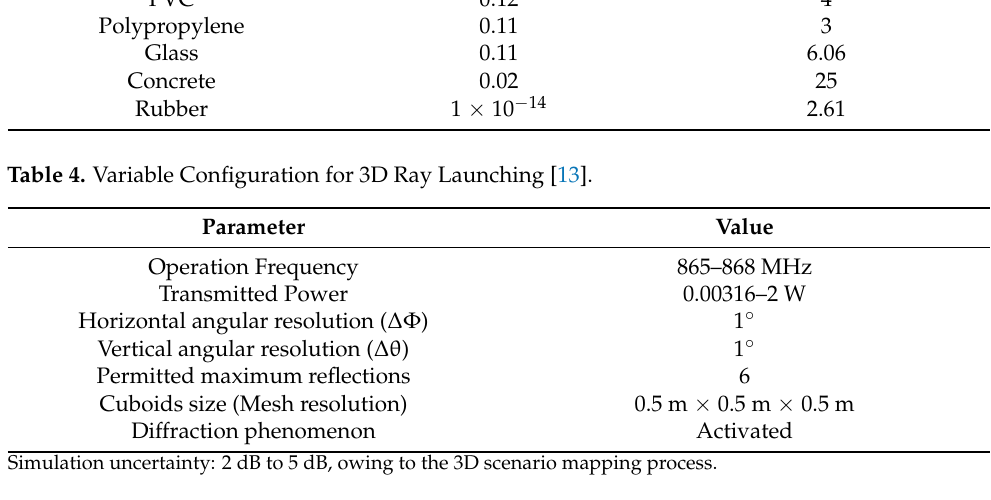
Table 4. Variable Configuration for 3D Ray Launching [13].